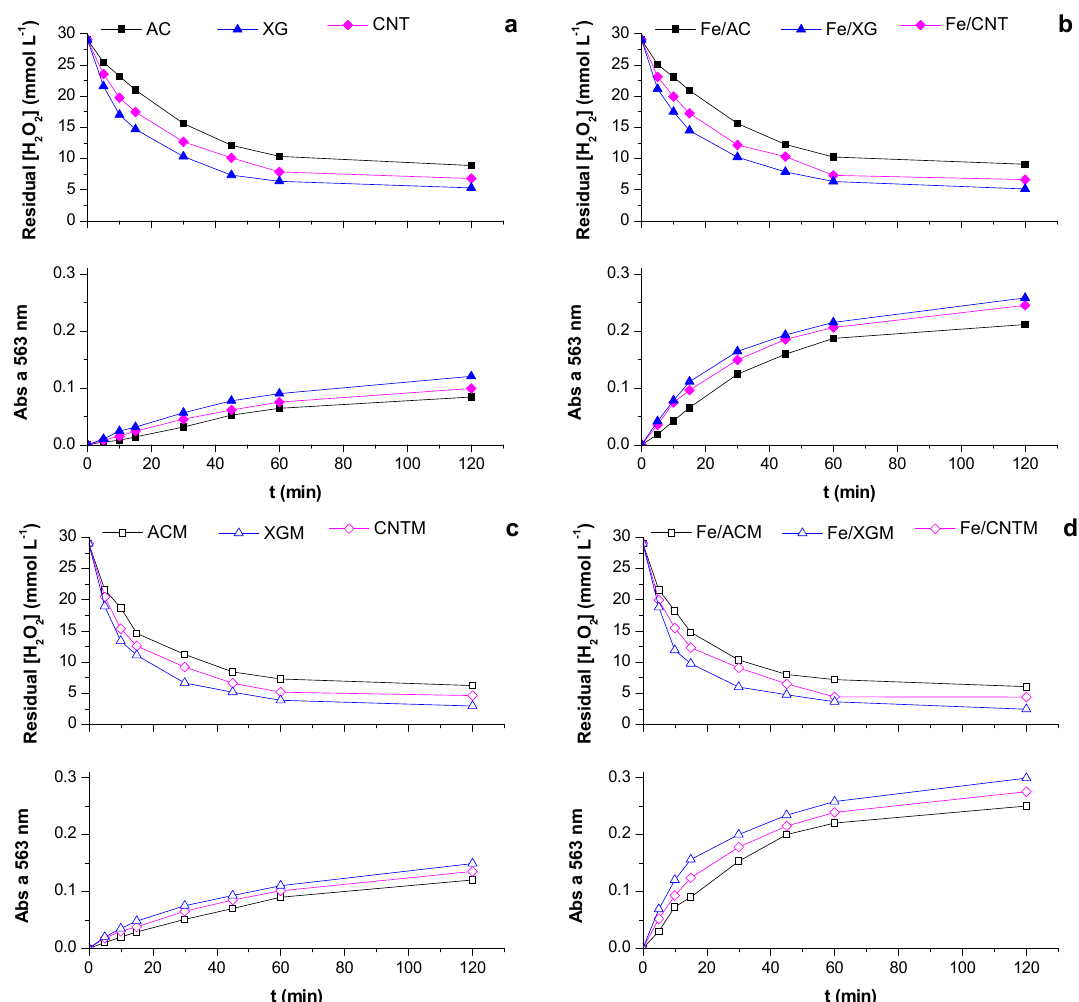
Figure 3. Consumption of hydrogen peroxide and hydroxyl radicals formation as a function of time for experiments with the supports ( a ) or with the iron supported catalysts ( b ) and supports ( c ) or catalysts ( d ) N-doped with melamine (pH = 3.0, T = 30 °C, [support or catalyst] = 0.25 g L −1 , [H 2 O 2 ] = 29 mmol L −1 and [PNP] = 0 mmol L −1 ).